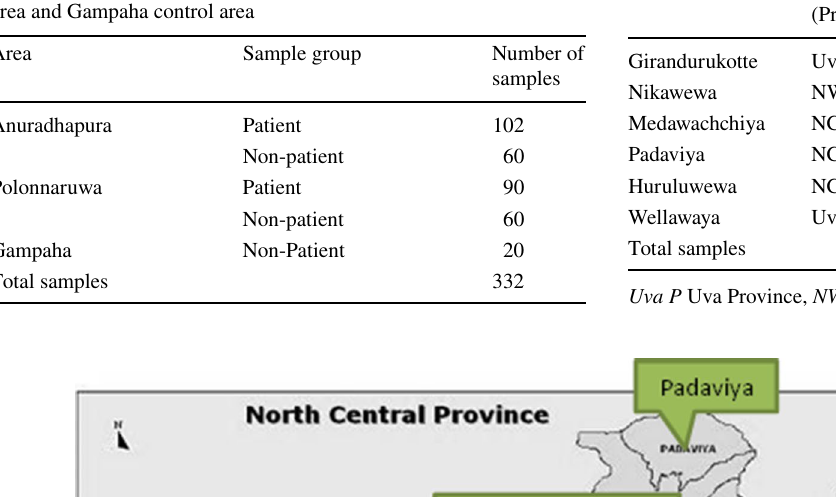
Table 1 Sampling groups and numbers from NCP CKDu endemic